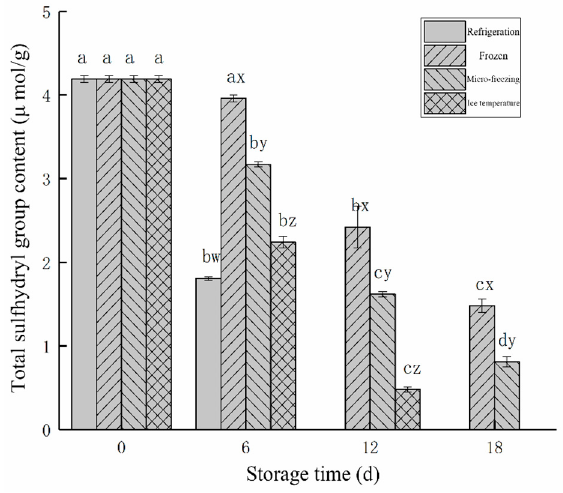
Figure 7. Changes in total sulfhydryl content during beef storage with different low-temperature